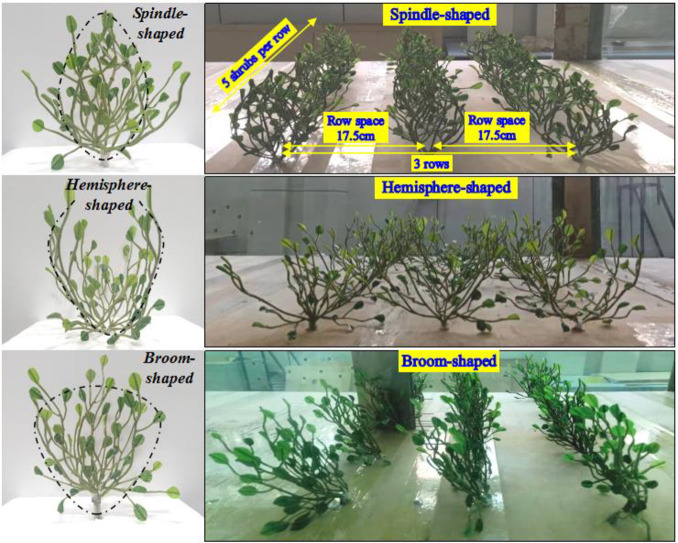
Configuration of synthetic shrubs (left) and arrangement in the test section of the wind tunnel (right).